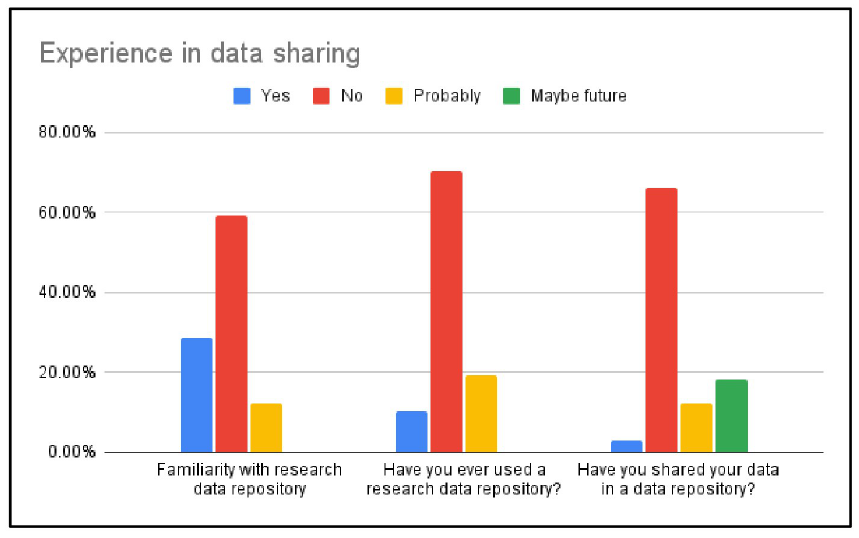
Fig 3. Experience in data